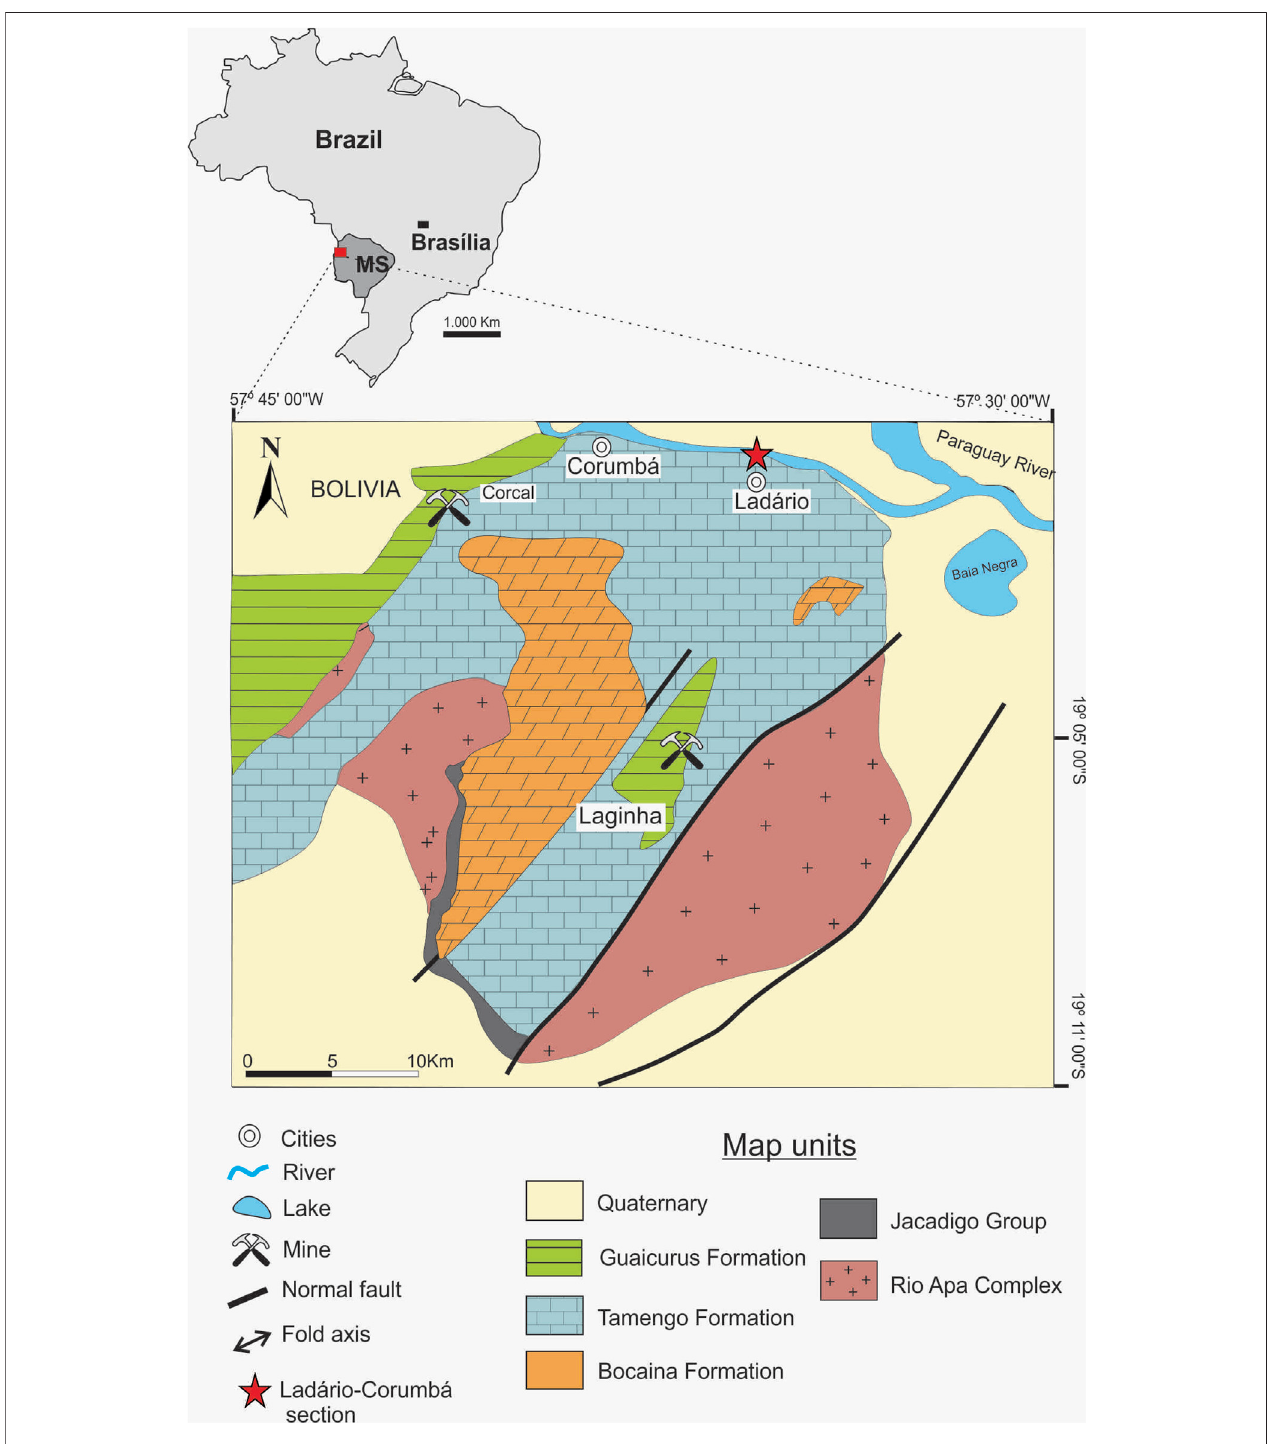
FIGURE1| Geological mapoftheParaguayBelt inSouth America, showingthelocationoftheCorumbá (Brazil)area, theLadário-Corumbá section (redstar), and the geology of the Corumbá Group.